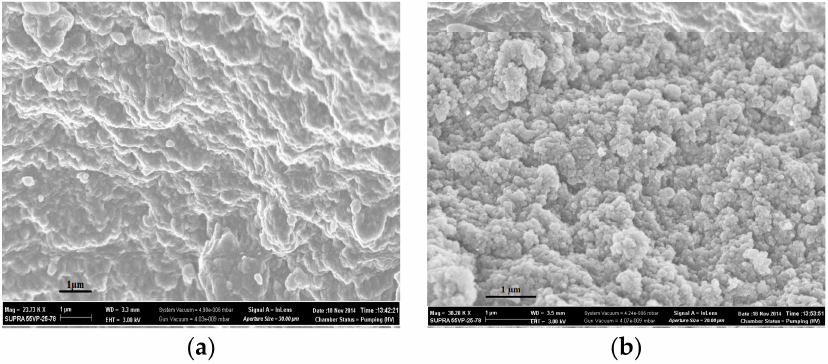
Figure 4. SEM of the surfaces of sorbents: network CP-2 ( a ) and network MIP-2-6 ( b